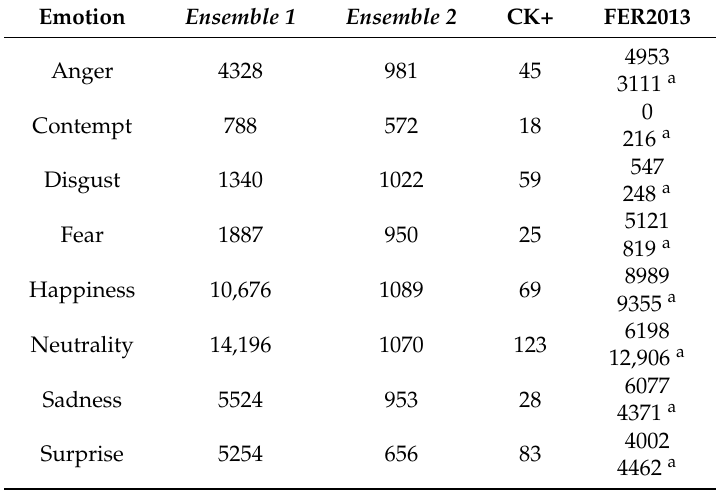
Table 1. Picture available for each emotion in the chosen